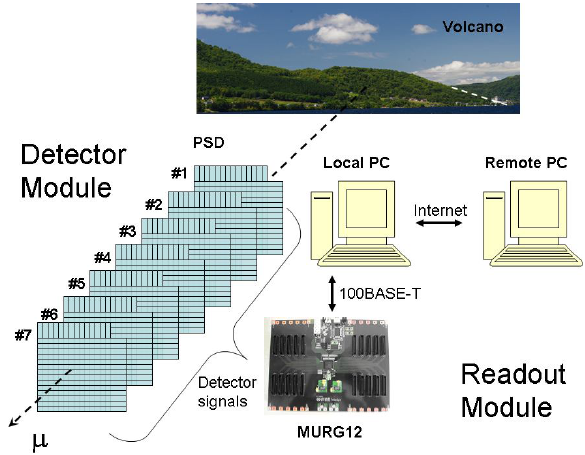
Fig. 1. 11 Fig. 1. Diagram of the observation system for multilayer muon high-speed radiography.